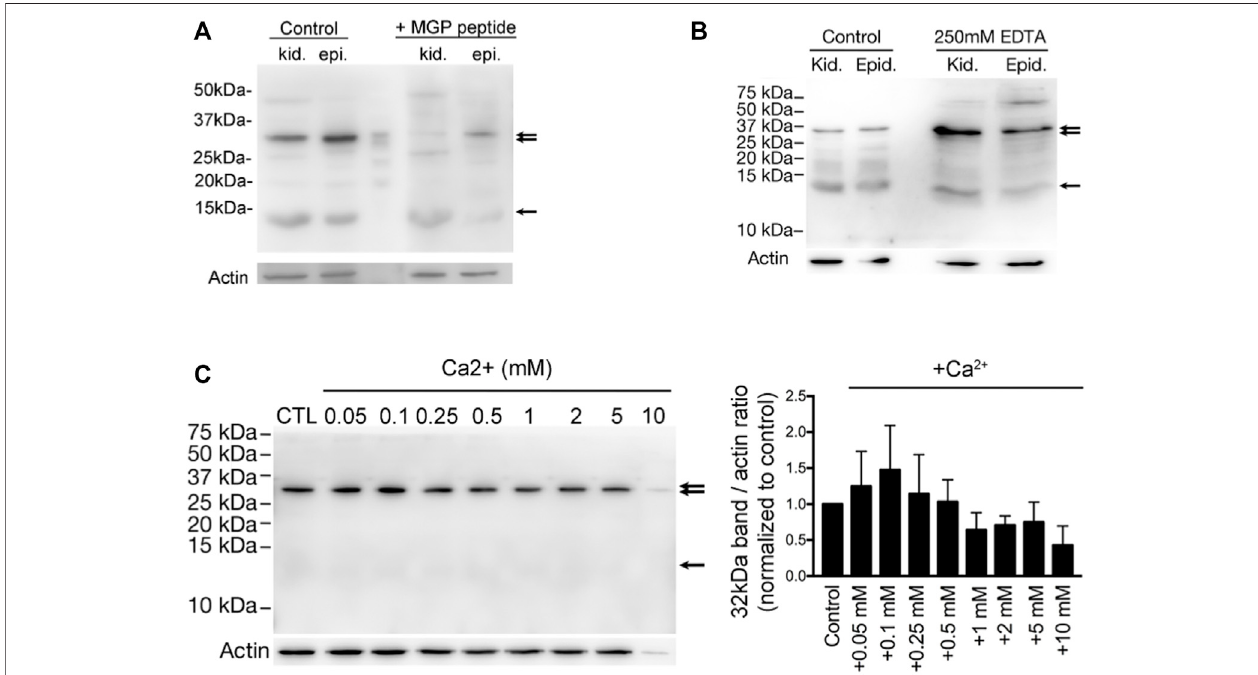
FIGURE 3 | Vitamin K-dependent MGP-mediated calcium-promoted aggregation of a protein complex with a prominent band of ~32-kDa. (A) Western blot detectionofanti-MGPintotalhomogenatesofkidney(kid.)andepididymis(epi.)fromWTadultrats.Abandat~12-KDa(arrow)correspondingtotheexpectedmolecular size of MGP, and another major band at around ~32-kDa (double arrow) were detected. Both bands were almost abolished by the preincubation with a ten-fold excess of the MGP immunizing peptide (+MGP peptide). (B) The intensity of ~32-kDa bands (double arrow) were signi fi cantly enriched in the low-Ca 2+ condition by addition of 250 mM EDTA to the protein lysates, whereas the ~12-kDa bands remained unchanged (arrow). Some bands at higher molecular sizes became obvious underthelow-Ca 2+ condition. (C) Thesameanti-MGPantibodywasusedtodetecttheintensitychangesof~32-kDabandinDC2cellproteinlysatesundervariousCa 2+ concentrations and the bar graph on the right shows the intensity of the band normalized to control (no additional Ca 2+ ). This suggests that MGP-mediated protein- aggregationisdependentonsub-millimolaramountofCa 2+ ,whereasexcessiveCa 2+ ( > 0.25 mM)inhibitsprotein-aggregation.(Originallypublishedin iScience (Maetal., 2019), with permission to reproduce from iScience